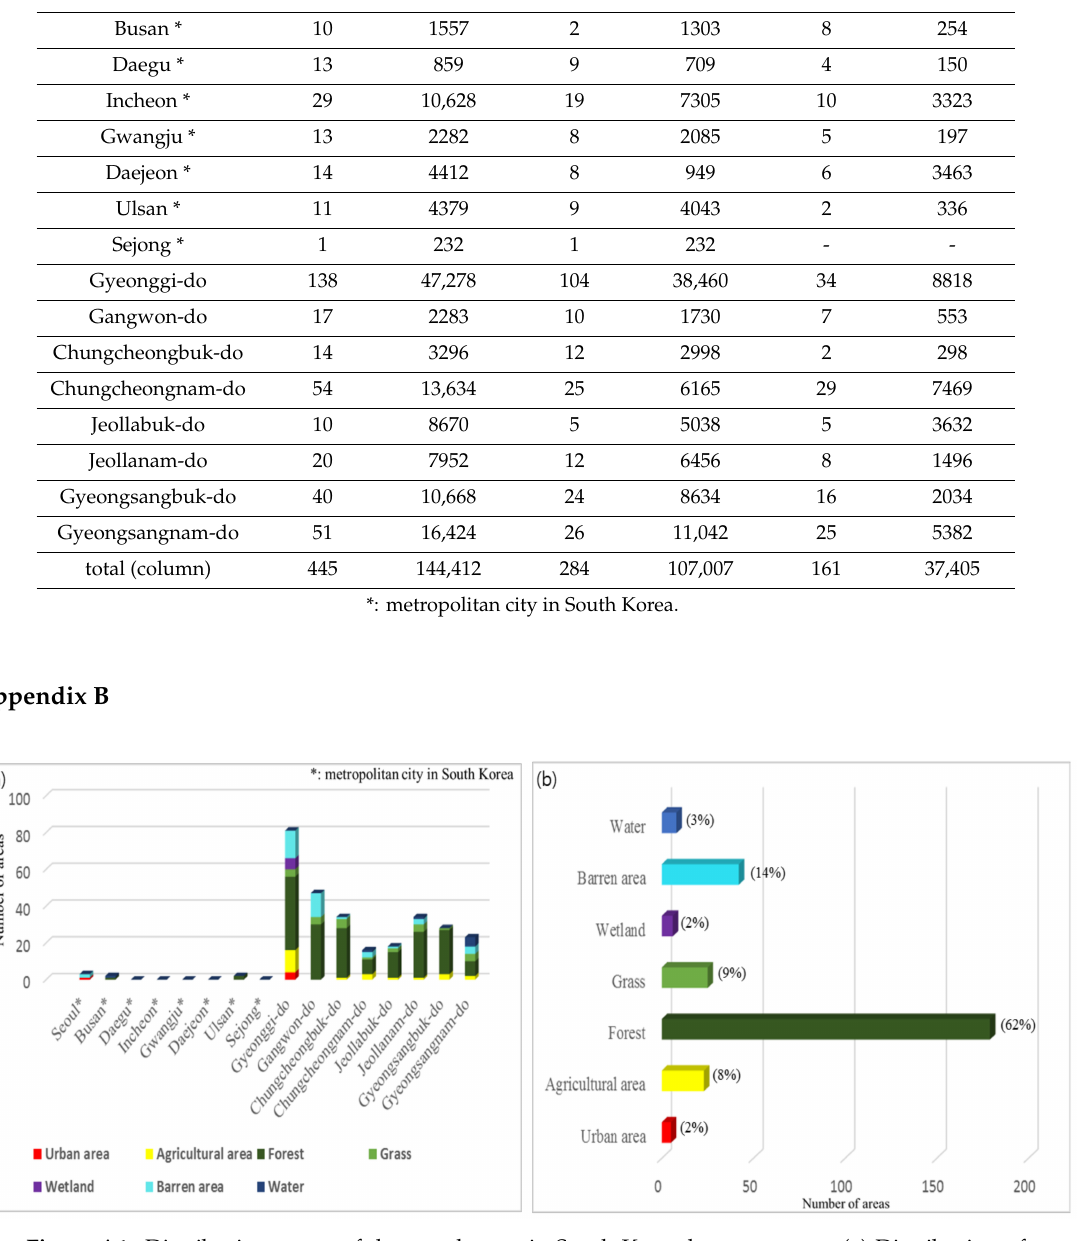
Figure A1. Distribution status of damaged areas in South Korea by ecosystem. ( a ) Distribution of damaged areas by ecosystem for each regional local government and ( b ) total distribution of damaged areas by ecosystem in South